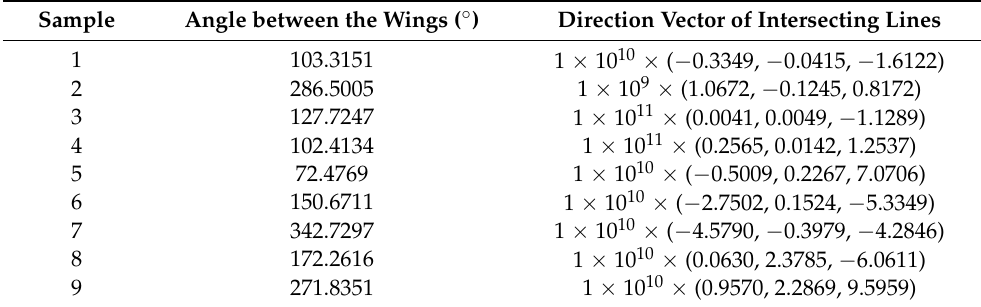
Table 1. Angle between the wings and the direction vector of intersecting lines for each sample. Sample Angle between the Wings (°)